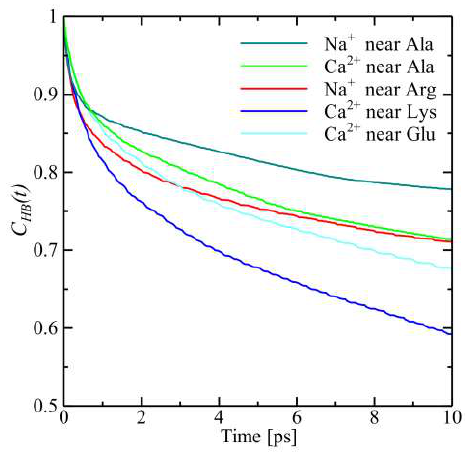
Figure 7. Hydrogen bond correlation functions of the cations.